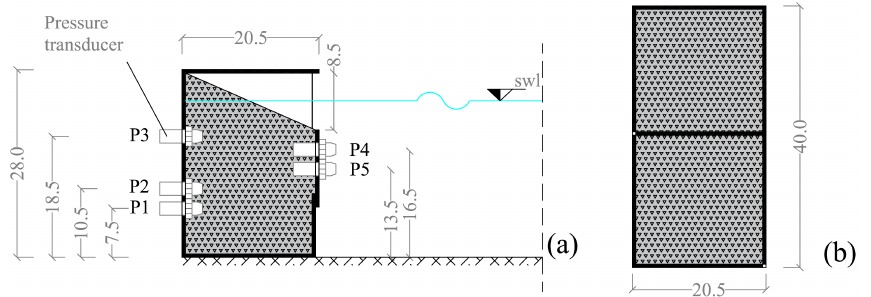
Figure 3. Cross section ( a ) and plan view ( b ) of the composite caisson (dimension in